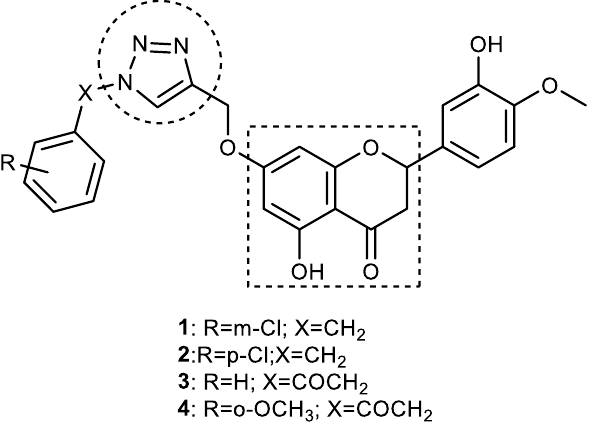
Figure 8. Chemical structure of hesperetin – 1,2,3-triazole hybrids.